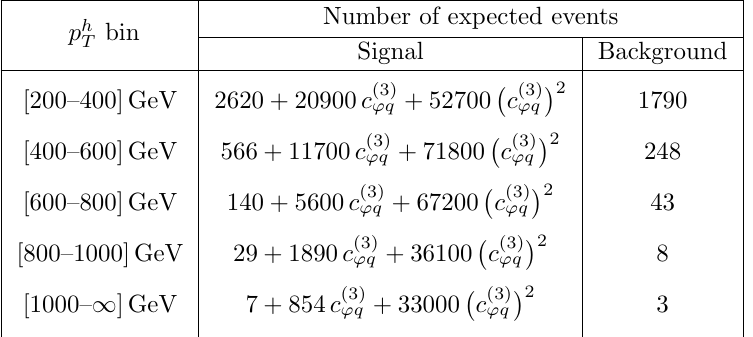
Table 5 . Number of expected signal and backgrounds events at FCC-hh with 30 ab events number is given as a function of c (3) ’q ((cid:12)xing (cid:3) = 1 TeV) and the contribution of Wjj to the background is